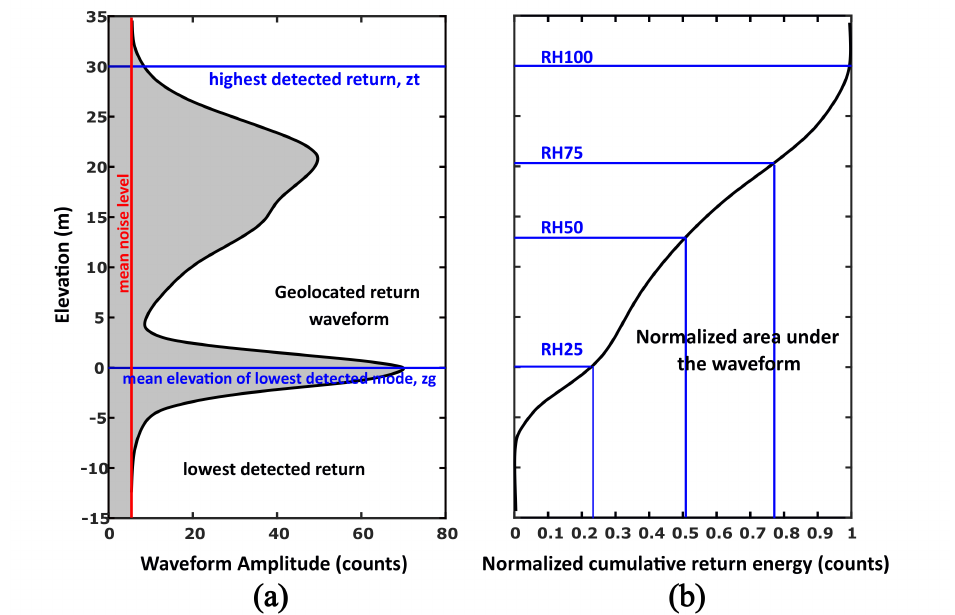
Figure 4. ( a ) Schematic view of the Lidar LVIS waveform divided into four zones. Zone 1: ground contribution; Zone 2: Canopy contribution, Zone 3 : Noise and unwanted reflected signal. ( b ) Extraction of Lidar Level 2 data from the LVIS waveform. RH100 is the elevation of the highest detected return (forest top height). RH25 is the elevation where 25% of the waveform energy occurs—it denotes the ground layer associated with LVIS